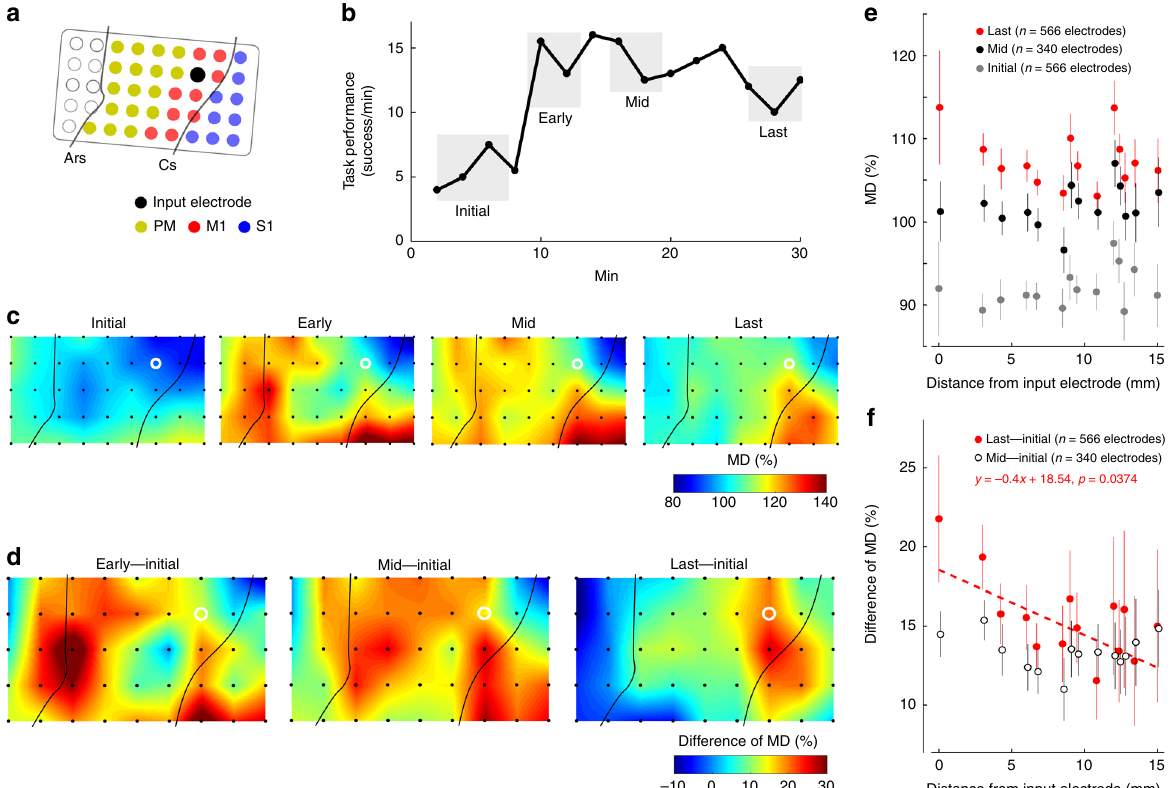
Fig. 4 Targeted cortical adaptation during learning with an ACMC. a The ACMC input electrode in M1 is shown as a fi lled black circle. Electrical stimuli were applied to the fl exor carpi radialis (FCR) muscle. Data were obtained from Monkey M. b Time course of task performance. The data obtained from the time intervals shown in grey shading were used to analyse the MDs of high-gamma activity. c Topographic map of MDs during the initial, early, mid, and last phases. d Differences in the MD spatial distribution between the initial and early, mid, and last phases. The white circles indicate the input electrode used for the ACMC. Electrodes not used for the ACMC are shown as black dots ( c – d ). Similar results were obtained from independent experiments in Monkey TE and M ( n = 17 sessions, see also Figs. 5 and 6, Supplementary Fig. 11). e The relationship between MD and distance from the input electrode in Monkey TE and M (Initial, n = 566 electrodes from 17 sessions; Mid, n = 340 electrodes from 10 sessions; Last, n = 566 electrodes from 17 sessions). The grey, black and red circles represent MD in the initial, mid, and last phases, respectively. The MD continuously increased over initial, mid, and last phases ( P < 10 − 5 by two-way ANOVA with Bonferroni ’ s correction for post hoc multiple comparisons). f The relationship between the difference of MD versus the distance from the input electrode in Monkey TE and M (Last - Initial, n = 566 electrodes from 17 sessions; Mid - Initial, n = 340 electrodes from 10 sessions). The black and red circles represent the difference of MD between the initial and mid phases (Mid - Initial) and between the initial and last phases (Last - Initial), respectively. A signi fi cant correlation between distance from the input electrode and difference of MD was found only in Last – Initial, shown as a red dotted line (Pearson correlation coef fi cient; R = − 0.0875, P = 0.0374). Data in ( e ), ( f ) are shown as means and standard errors;